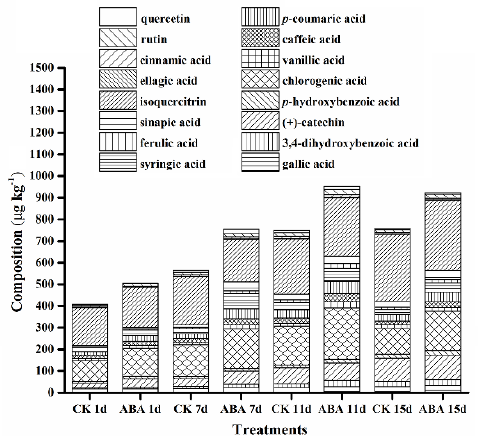
Figure 3. The visual results of the composition of phenolic compounds in the tomato at the mature green, breaker, turning, and red stages, respectively.